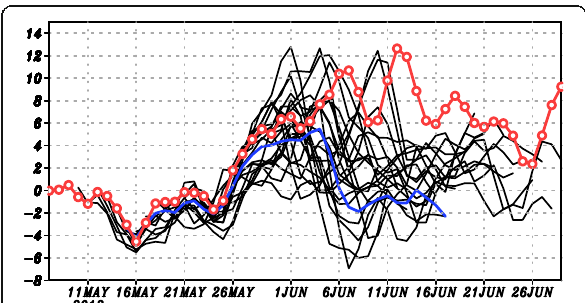
Fig. 5 Time series of the Indian summer monsoon indices for the ensemble simulations. The black curves are for each run, the blue curve is for averaging five members with initial conditions covering May 15 – 19, and the red curve is for the actual observations. The Indian summer monsoon index is defined as the meridional shear of zonal winds at 850 hPa over the Indian continent (40°E – 80°E, 5°N – 15°N minus 70°E – 90° E, 20°N – 30°N). After Fig. 1 of Kajikawa et al.